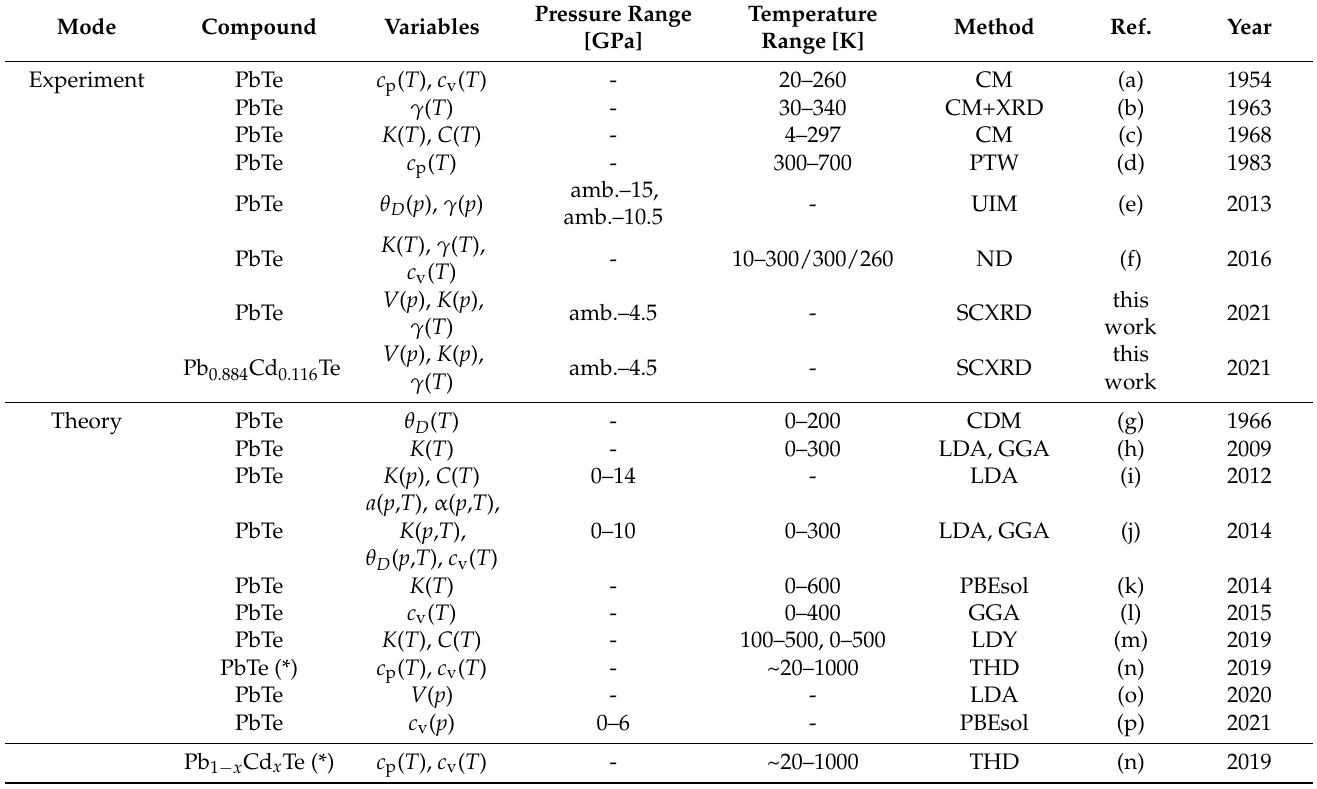
Table 5. (Completing Tables 2–4). Pressure and/or temperature ranges for experimental and theoretical studies of structure- related variables for PbTe and Pb 1 − x Cd x Te ( x = 0.116), reported as functions of pressure and/or temperature: volume on pressure dependence, V ( p ), bulk modulus, K ( T ), elastic constants, C ( T ), Debye temperature, θ D ( p , T ) or θ D ( p ), Grüneisen parameter, γ ( T ) and γ ( p ), thermal expansion, α ( p , T ), heat capacity, c p ( T ) or c p ( T ). For experimental studies, the ranges refer to the lower and upper limit of the